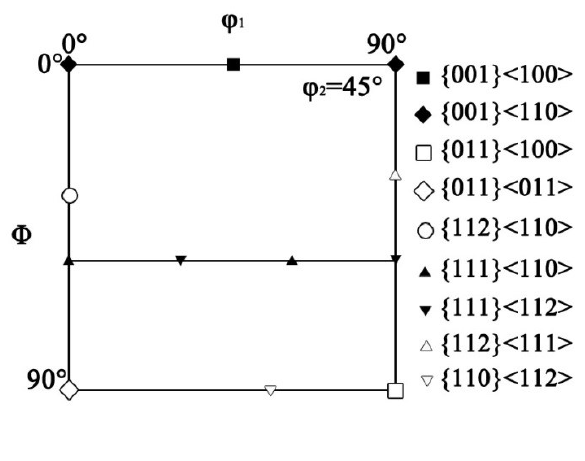
Figure 6: Ideal preferred orientations in the Euler space